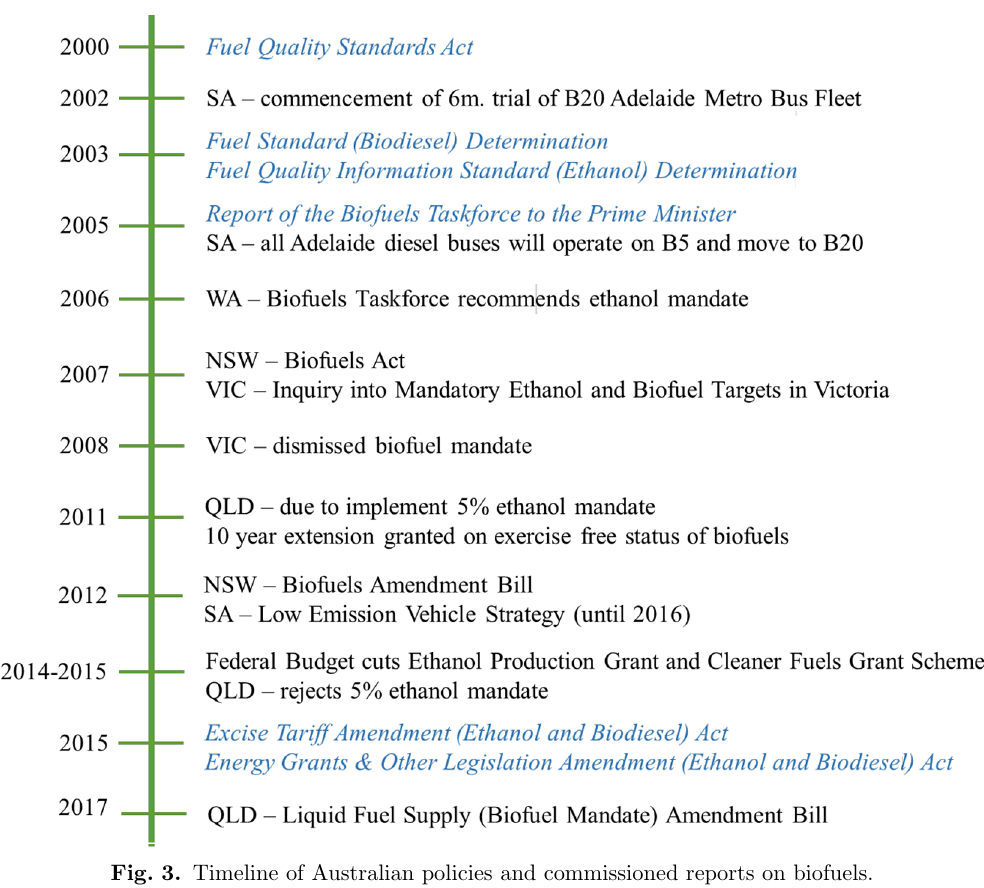
Fig. 3. Timeline of Australian policies and commissioned reports on